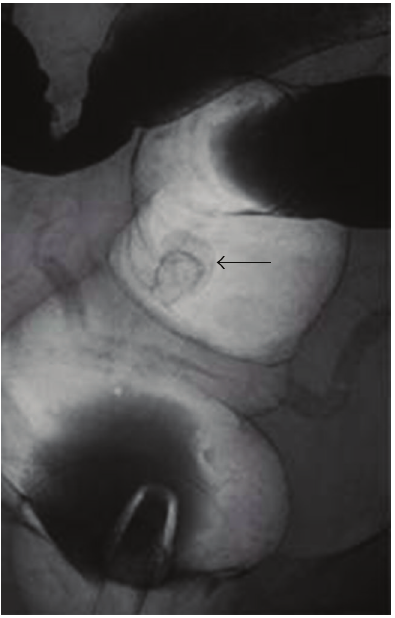
Figure 3: In case 3, an air contrast barium enema also revealed a pedunculated polyp like a snowman shape (arrow) in the sigmoid